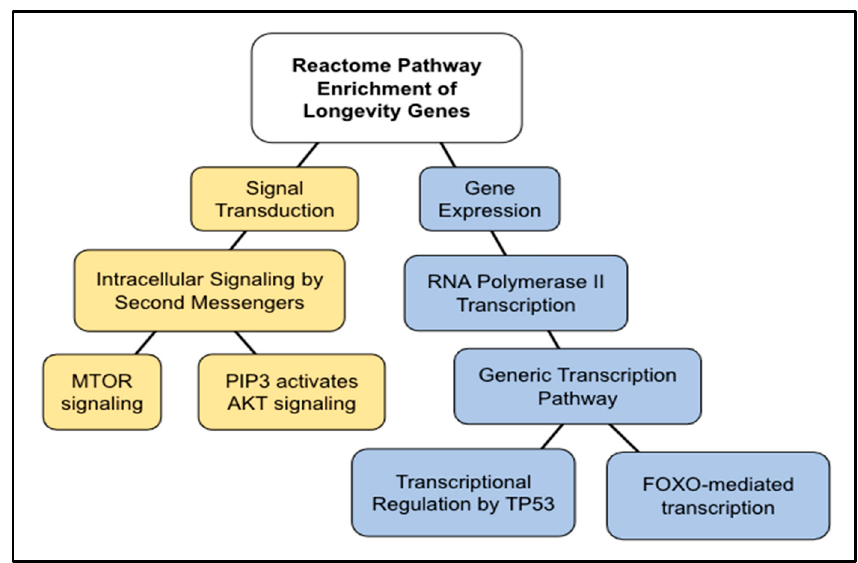
Figure 9. Diagram of the Reactome pathway enrichment of longevity genes. The results shown in Table 3 are summarized. Two main pathways are shown out of twelve pathways identified.